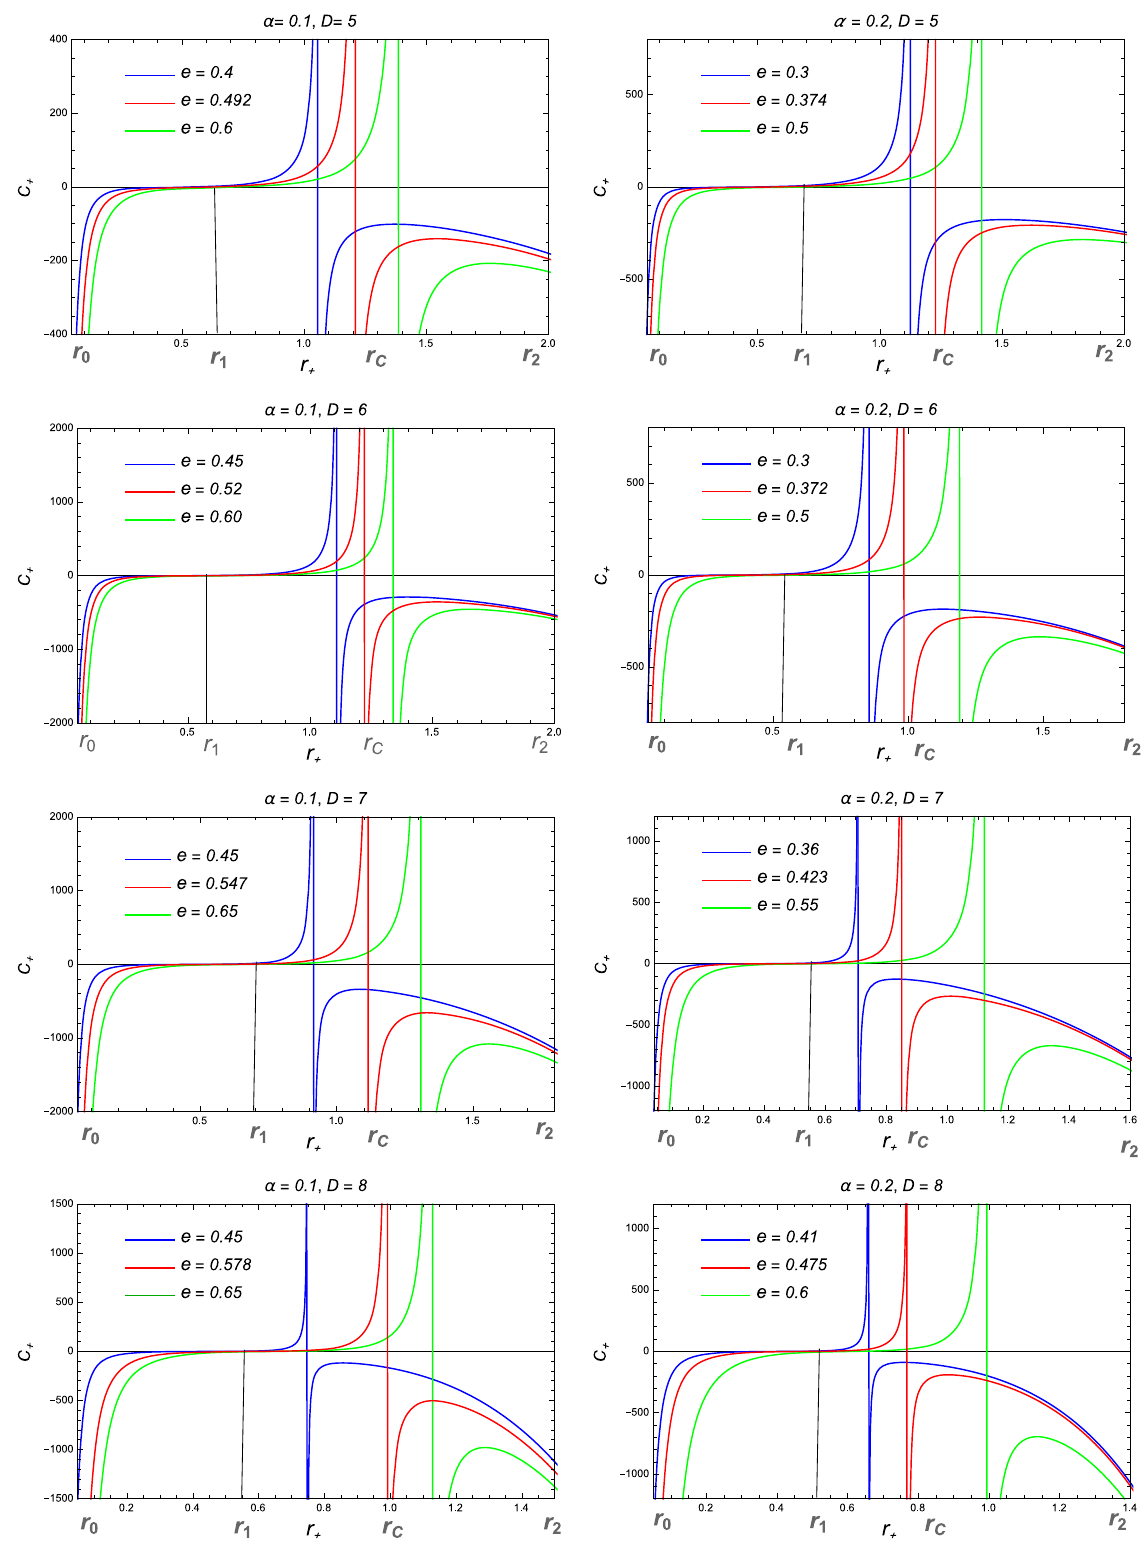
Fig. 4 The specific heat C + vs horizon radius r + in various dimensions D = 5, 6, 7, and 8 (top to bottom) for different values of charge e with Gauss–Bonnet coupling parameter α = 0 . 1 and 0.2 (left to right) with μ (cid:9) =